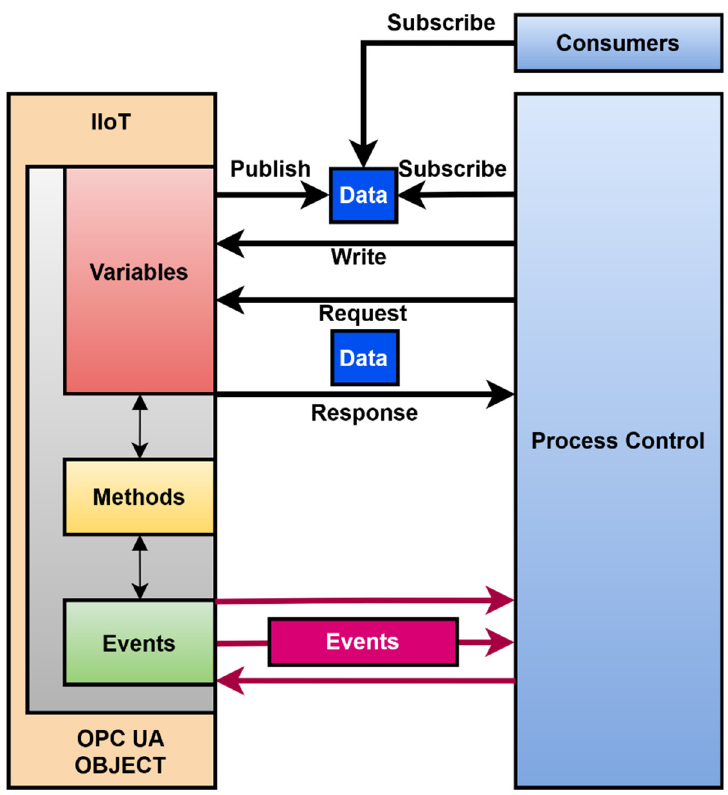
Figure 23. IoT device design and integration options.